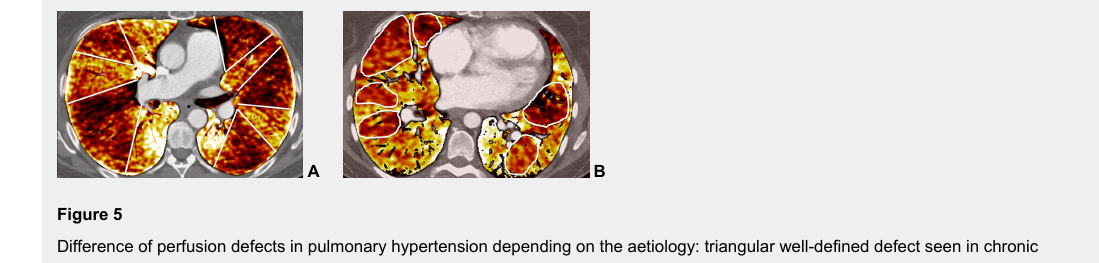
Difference of perfusion defects in pulmonary hypertension depending on the aetiology: triangular well-defined defect seen in chronic thromboembolic pulmonary hypertension ( A ) and poorly defined defect with mottled pattern seen in idiopathic pulmonary arterial hypertension ( B ).